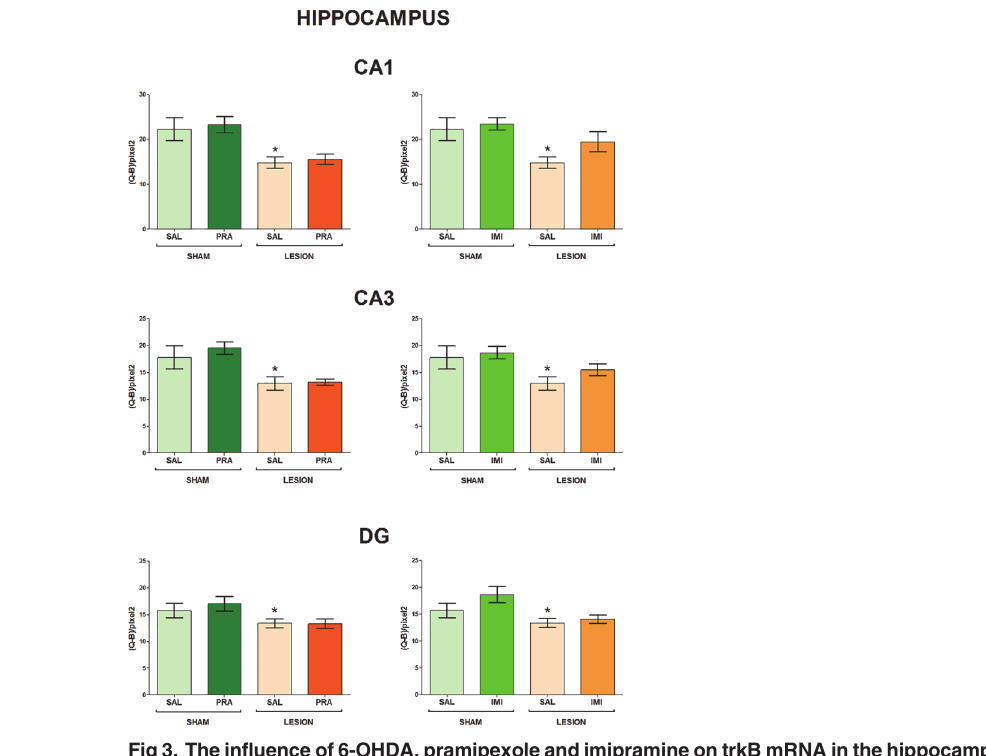
Fig 3. The influence of 6-OHDA, pramipexole and imipramine on trkB mRNA in the hippocampus. n = 9 – 10. For further explanations see Figs. 1 and 2.